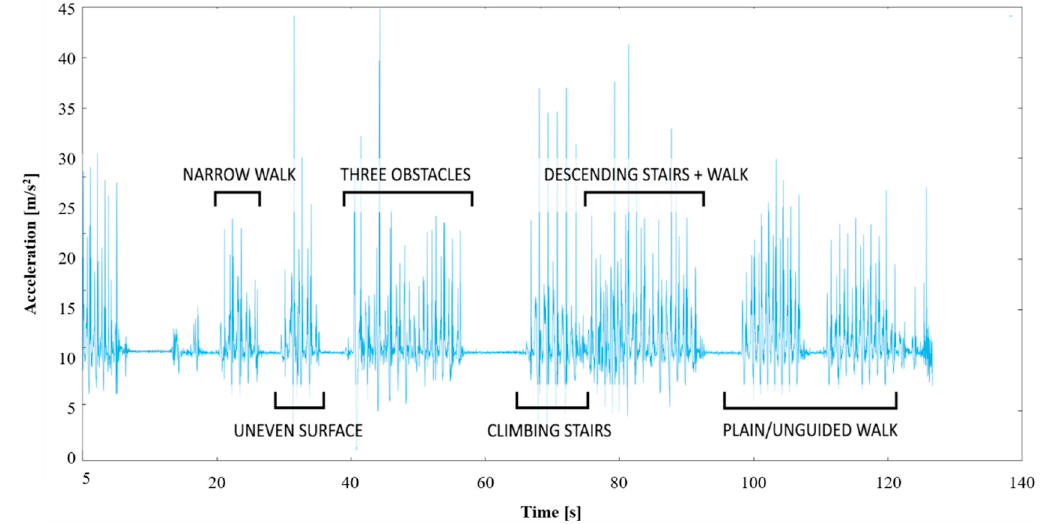
Figure 5. Variation in stride time for one participant while walking in the obstacle course. Table 1. Descriptive statistics of the participants, test results, and falls.